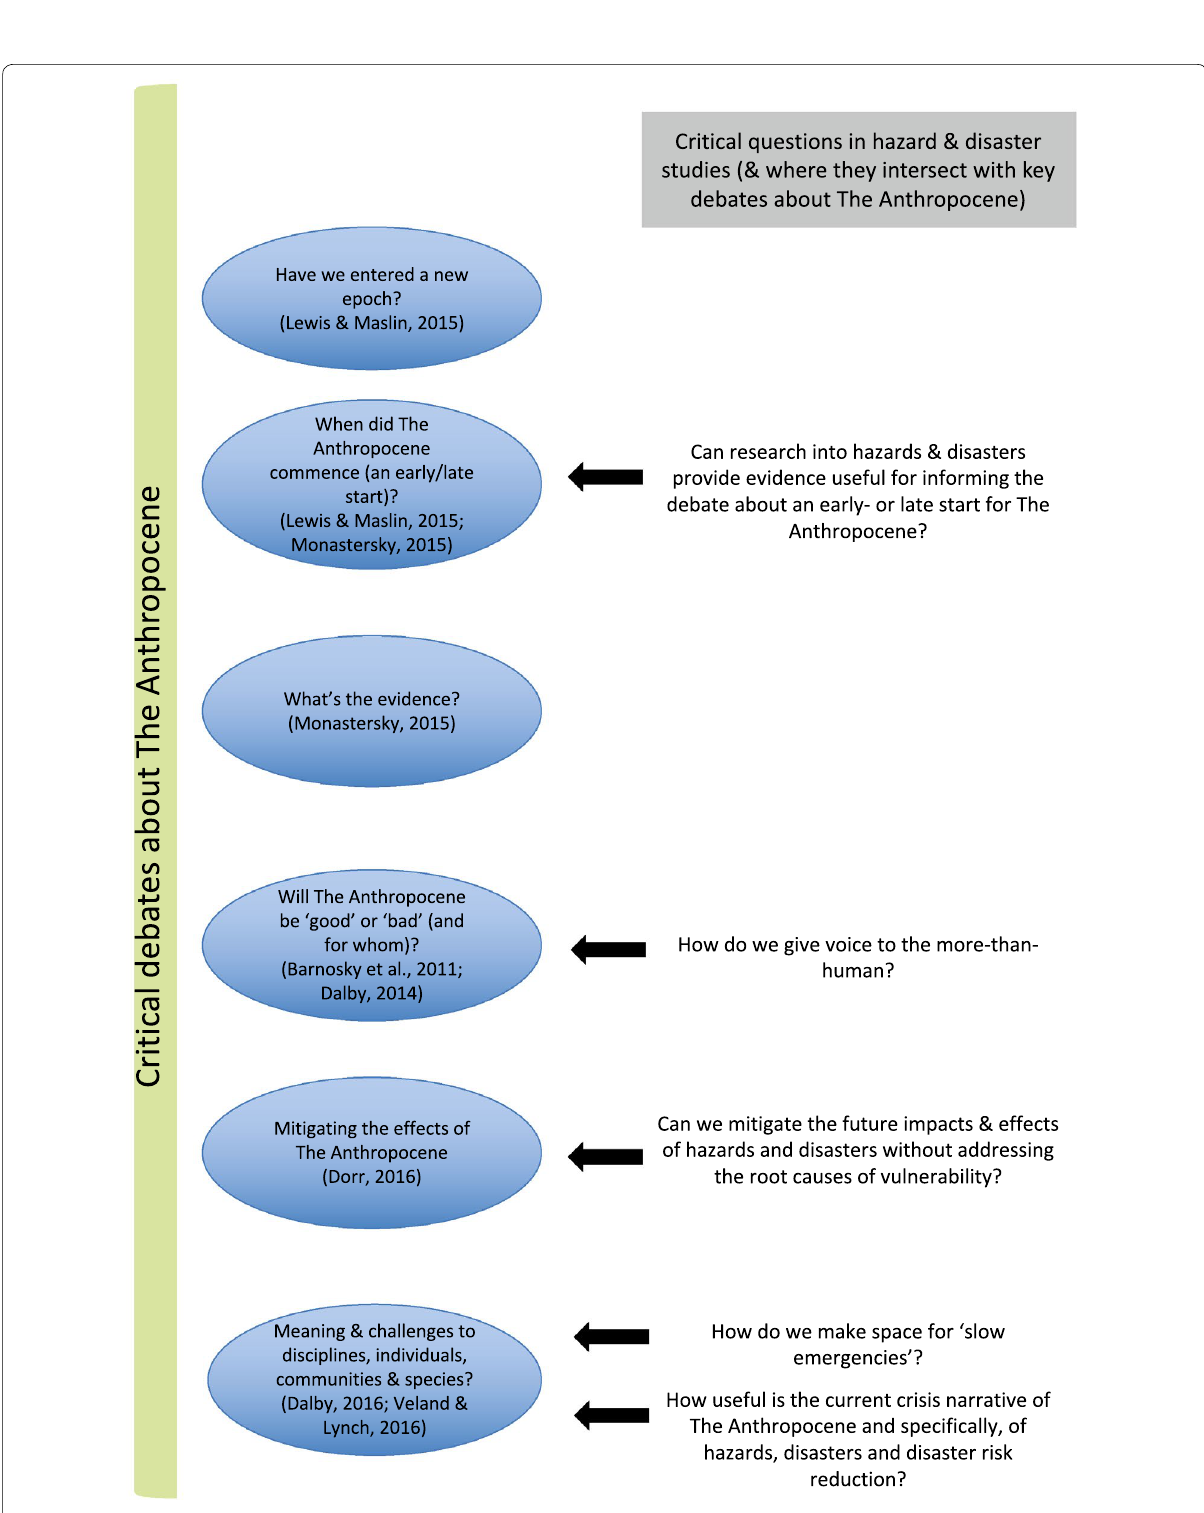
Fig. 1 Critical debates about the Anthropocene and reflective questions in hazard and disaster studies that intersect with these